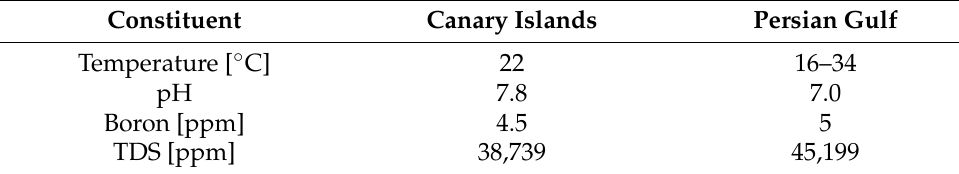
Table 2. Seawater composition (data from